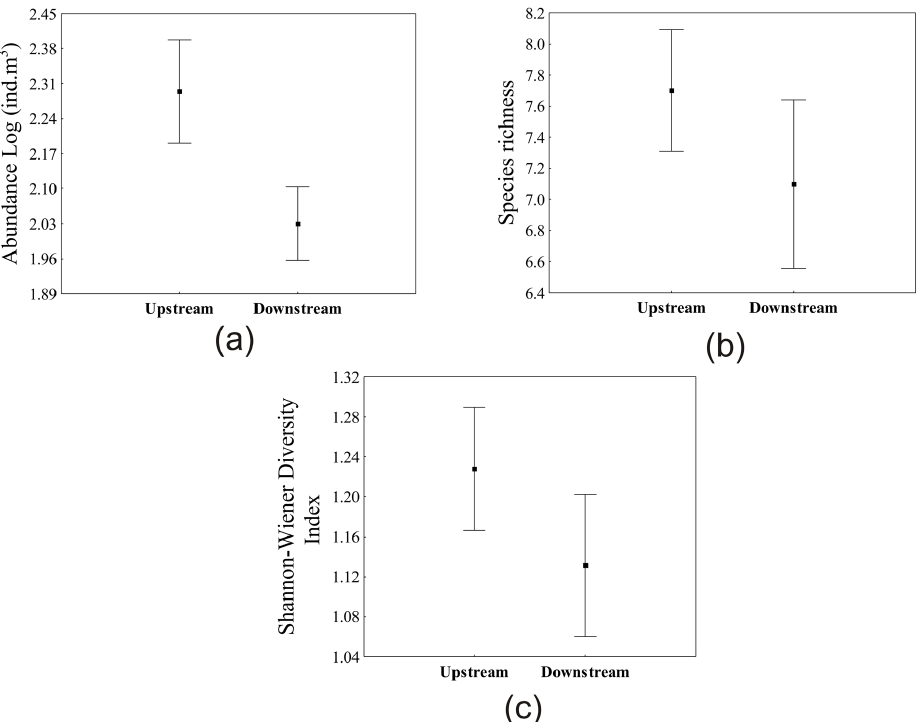
Figure 4. Copepod abundance (a), species richness (b) and diversity (c) in the sampled stretches (upstream and downstream) of the main channel of the Paraná River. Symbols represent mean values and vertical bars represent standard error.